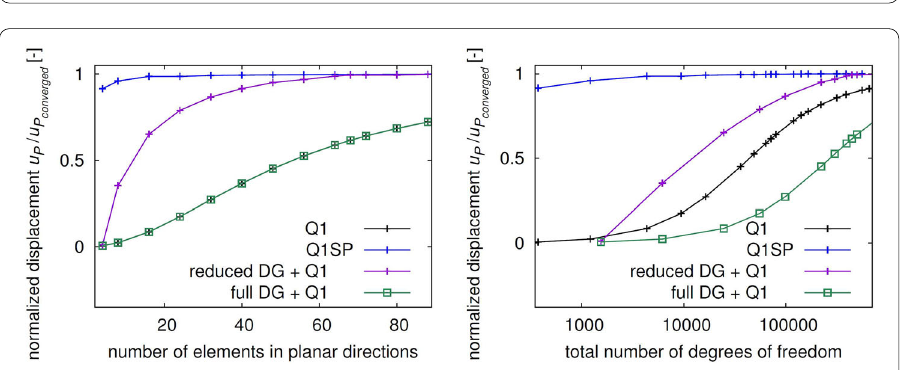
Fig. 13 Normalized vertical displacement of the point P in the thin plate as a function of the number of elements in each planar direction (left) and the total number of the degrees of freedom (right) for Q1, Q1SP, DG and their combinations with η = 10